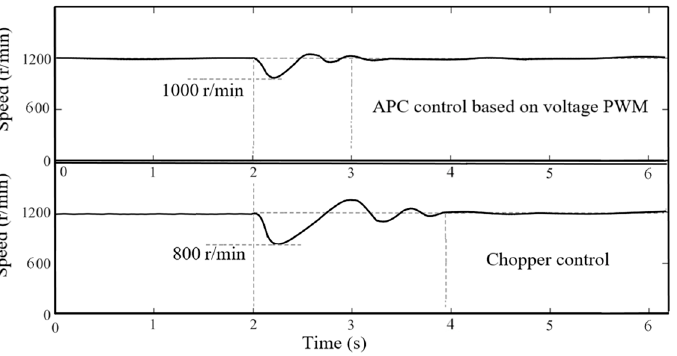
Figure 16. Comparison of the speed transition process with sudden torque increase.